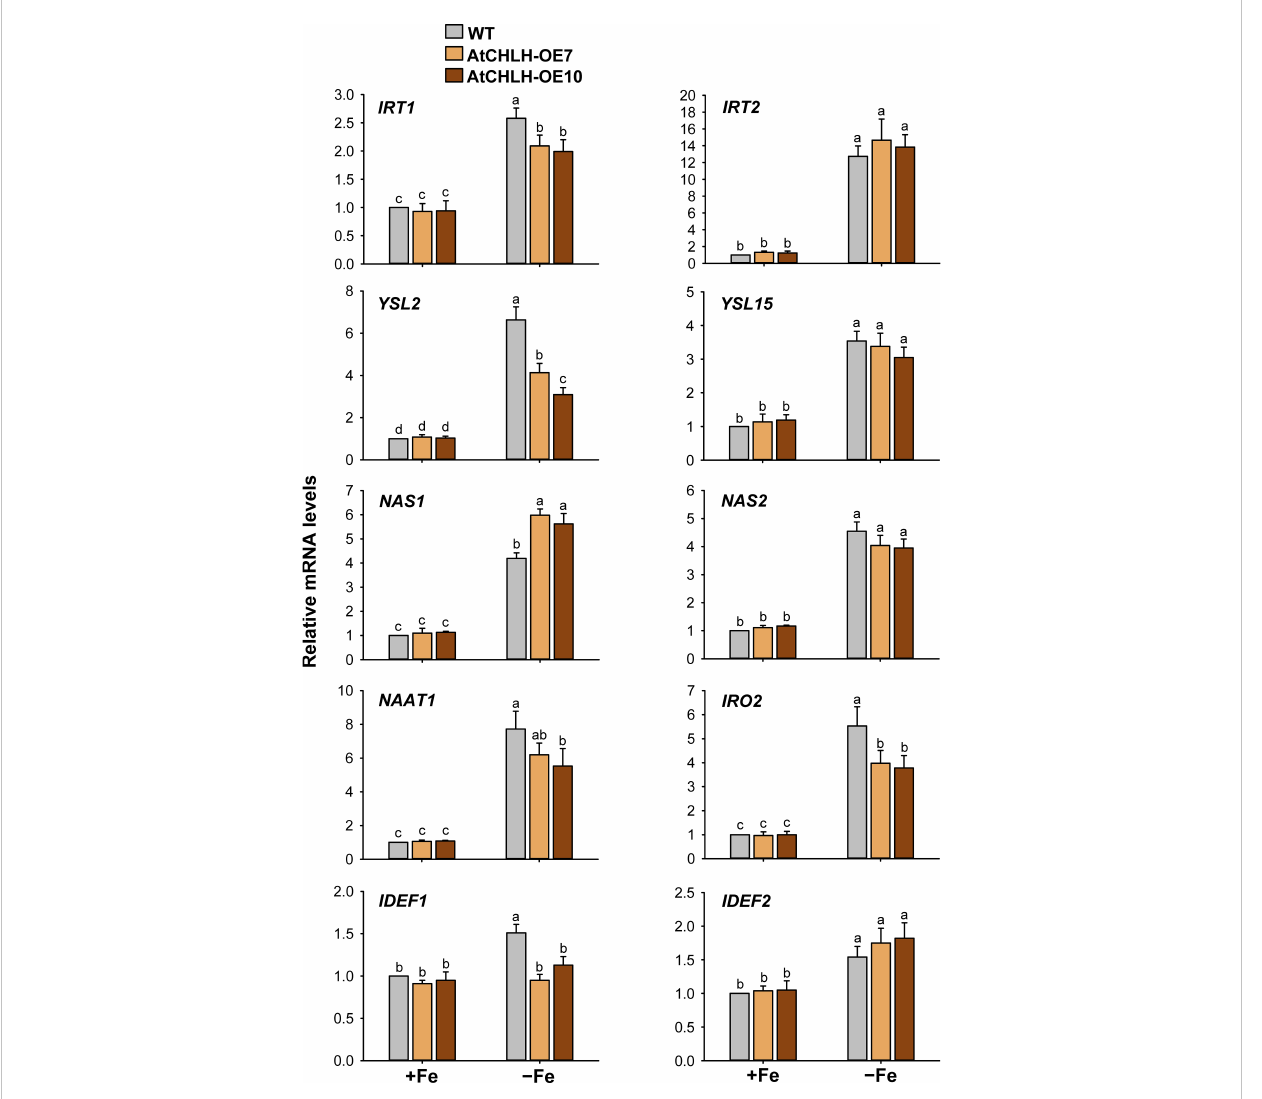
FIGURE 6 Expression of Fe transporter and Fe de fi ciency-induced transcription factor genes in roots of WT and transgenic plants. The plants were subjected to the same treatments as in Figure 3. Treatment notations are the same as in Figure 3. The general steps performed during the RT-qPCR experiment, from RNA isolation to data analysis, are outlined in Figure 4. Values are means ± SE, and data from three independent experiments are presented. Different letters indicate signi fi cant differences at P < 0.05 by Duncan ’ s multiple range